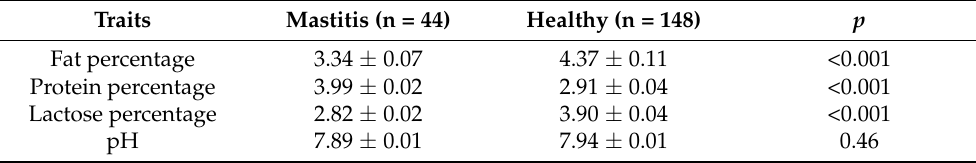
Table 2. The milk components changed by mastitis.